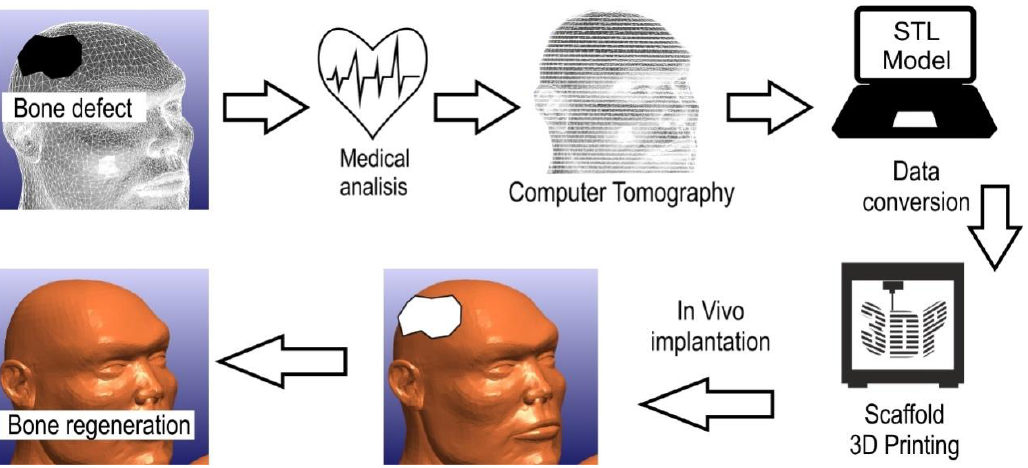
Figure 7. Scheme showing the procedure for manufacturing scaffolds for guided bone regeneration based on [300].